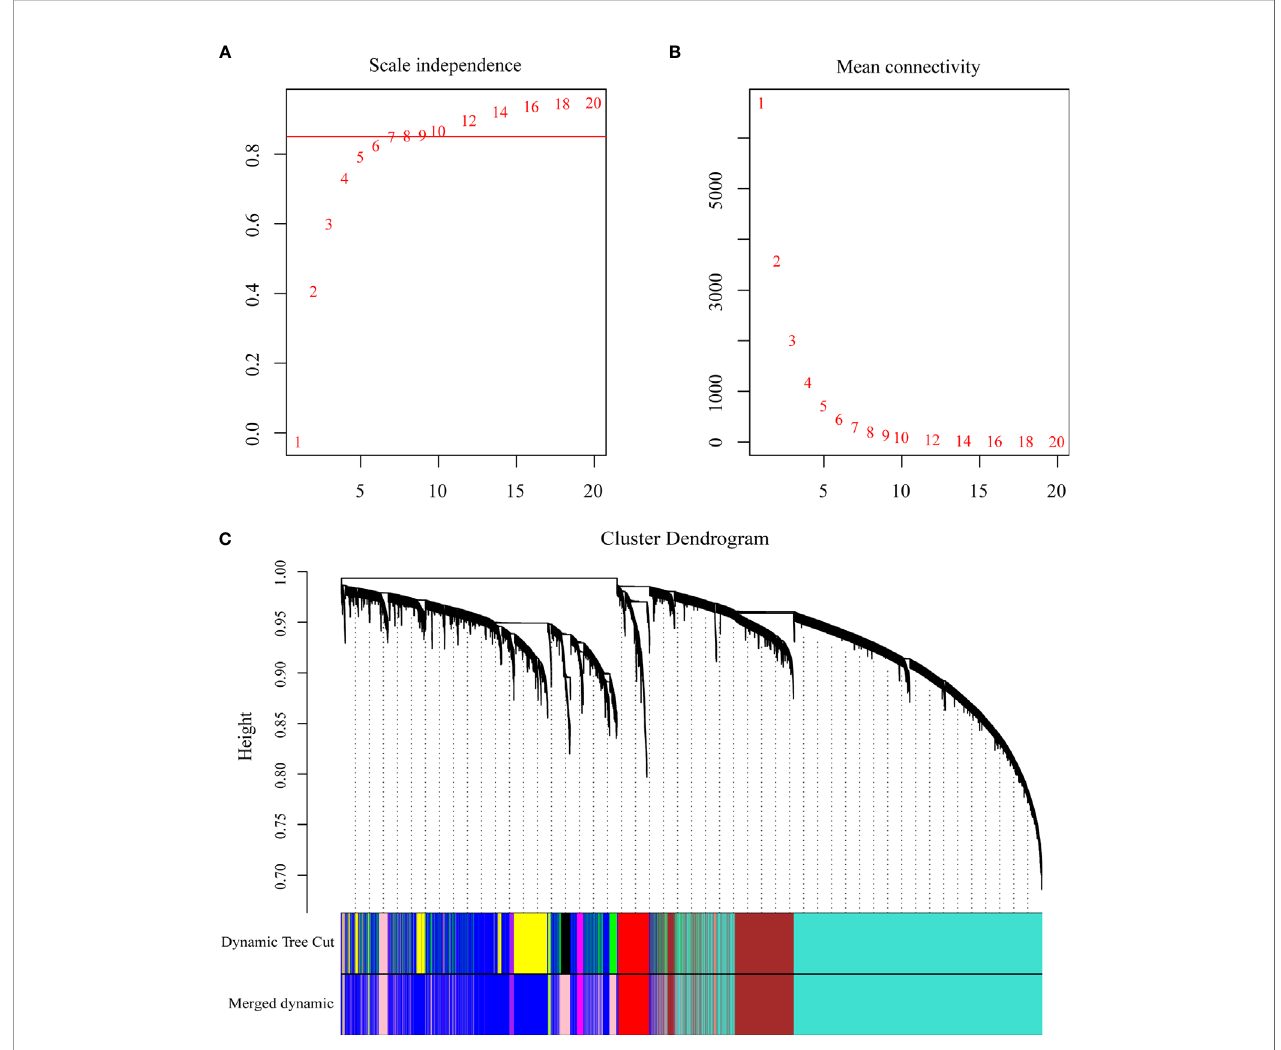
FIGURE 1 | WGCNA on the dynamic progression of MM. (A) Analysis of network topology for various soft threshold powers ( b ). (B) Mean connectivity with various soft threshold power. (C) Clustering dendrogram of all differentially expressed genes with assigned module colors. Each color block represented a module of highly co-expressed